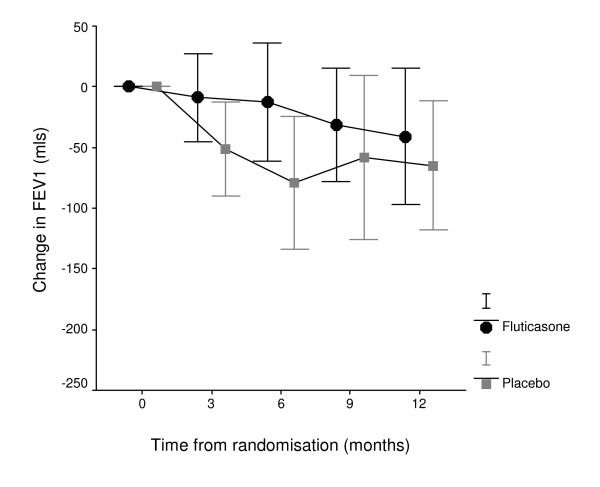
Change in forced expiratory volume in one second (FEV1) at three monthly assessments in study. Baseline FEV1 was value at randomisation. Mean difference for FEV1 (mls) at 12 months: fluticasone -41mls, placebo -64mls (P = 0.44).